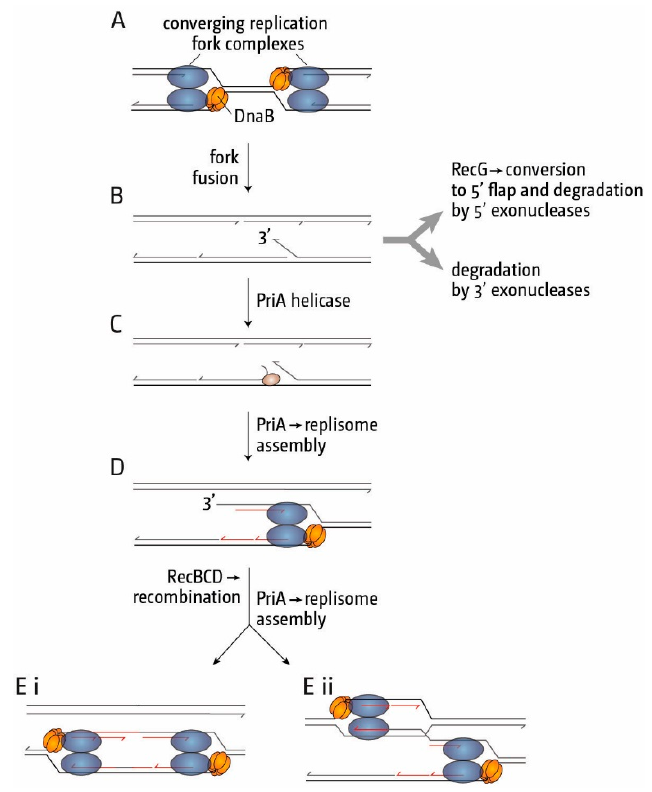
Figure 7. Schematic illustrating how replication fork fusions might lead to the formation of new divergent forks via PriA ‐ mediated replisome assembly and RecBCD ‐ mediated recombination, and how this can be normally suppressed by RecG and/or 3’ exonucleases. The formation of a 3’ flap can occur at both forks. However, for simplicity the schematic details only one such reaction. See text for further details.